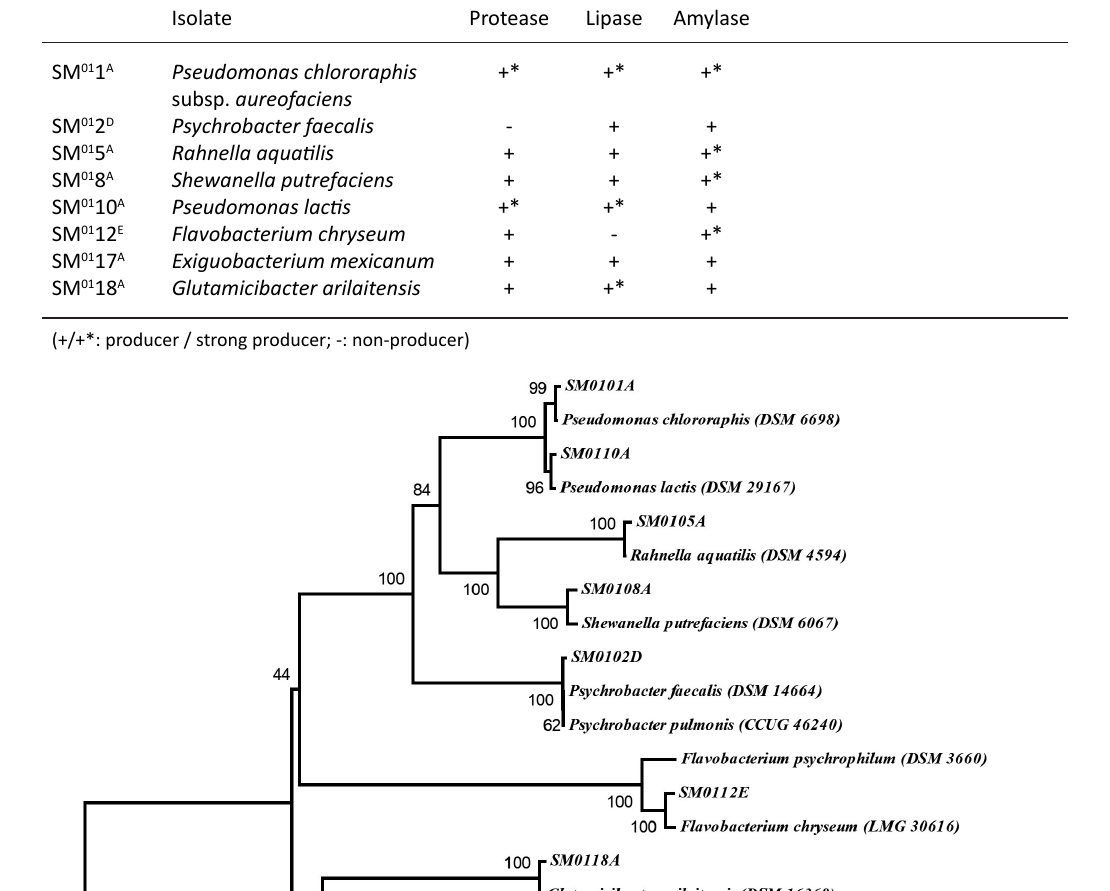
Table 2. Industrial enzyme production abilities of cold-adaptive isolates Isolate Protease